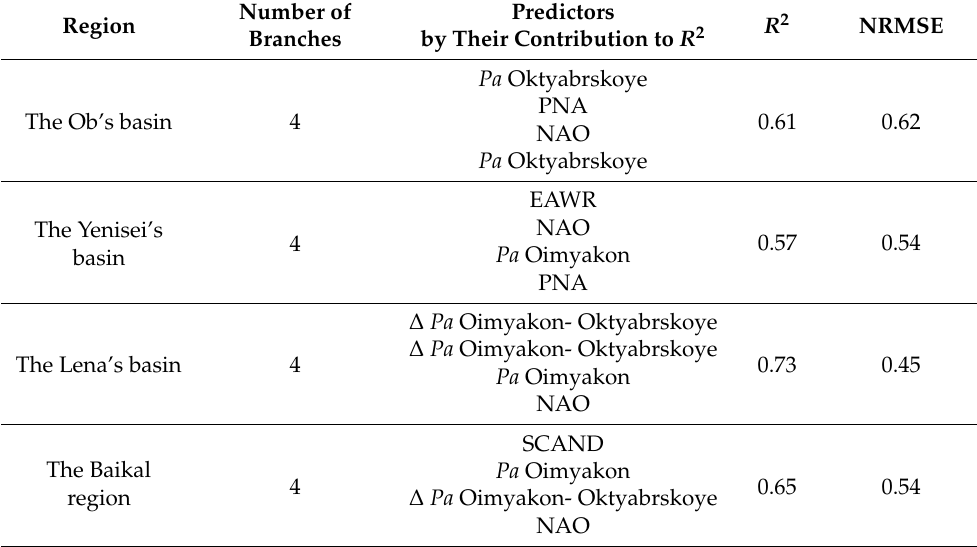
Table 4. Estimates of modeling the annual values of precipitation for four quasi-homogeneous regions of Siberia using the CART algorithm for